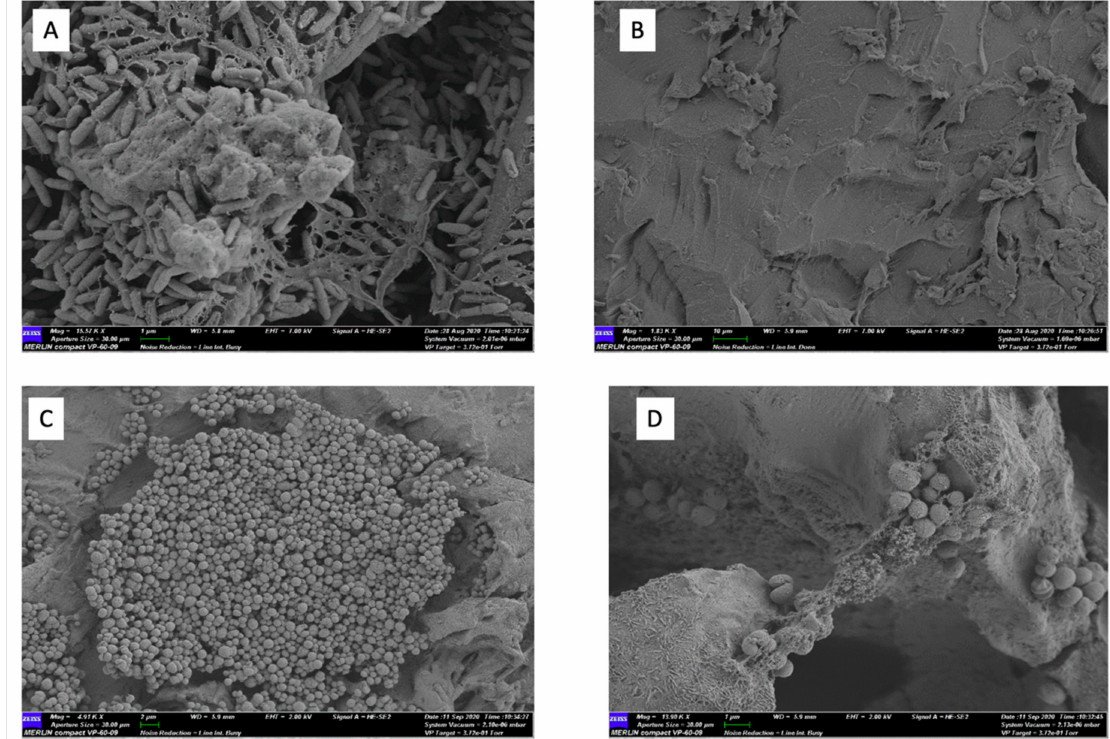
Figure 4. SEM image of P. aeruginosa ATCC-15442 biofilm on a polycarbonate coupon ( A ) untreated control at 15,570 magnification and 1 µ m and ( B ) treatment with topical MSA-DMSO gel solution for 30 s at 1830 magnification and 1 µ m. SEM image of S. aureus ATCC-6538 biofilm on a polycarbonate coupon ( C ) Untreated control at 4910 magnifica- tion and 2 µ m and ( D ) treatment with topical MSA-DMSO gel solution for 30 s at 13,900 magnification and 1 µ